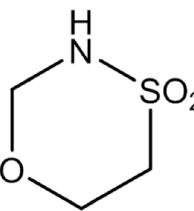
Figure 1. Molecular structure of the oxathiazine derivative substance GP-2250 (1.4.5-oxathiazan-dioxid-4.4).